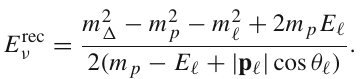
adopts four different values of the Dirac CP phase δ D = 0 ◦ (red), 90 ◦ (blue), 180 ◦ (green), and 270 ◦ (purple) to make comparison. On the other hand, the background is divided into CC (pink) and neutral cur- rent (NC, yellow)